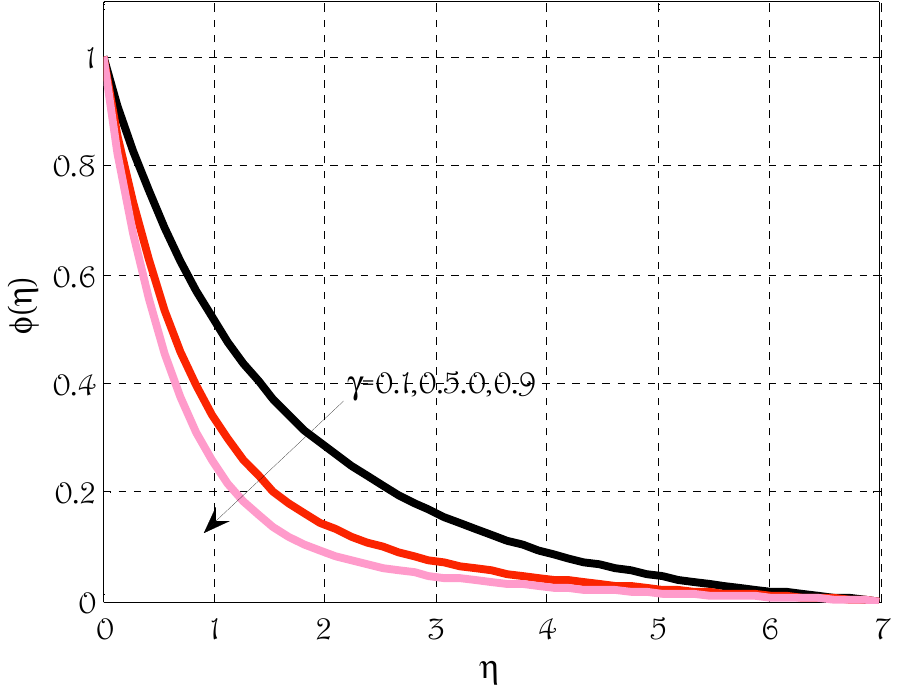
Figure 13. Effect of reaction rate parameter γ on concentration profile φ using k p = 0.5, M = 0.5, E c = 0.4, λ = 0.1, S c = 1.5, N t = 0.1, P r = 1.5, R d = 0.7, N b =